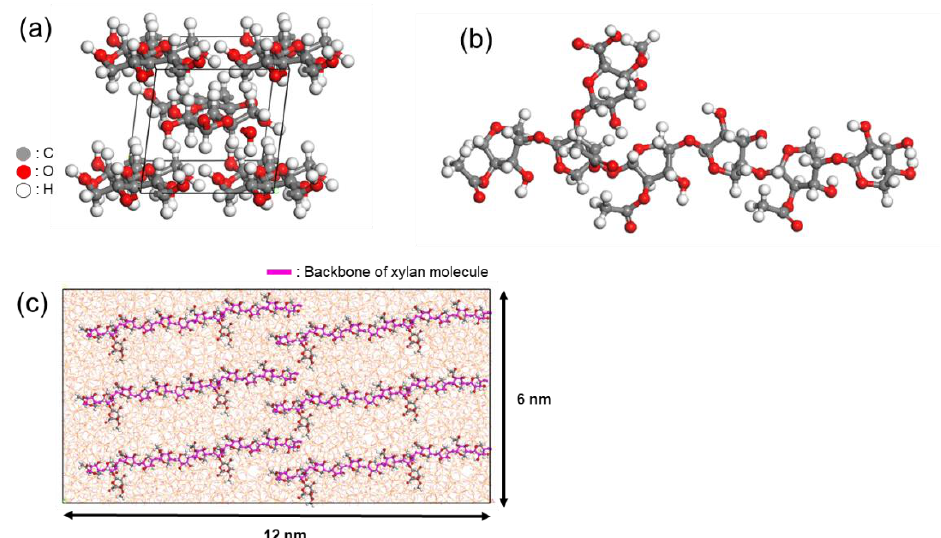
Figure 7. ( a ) Monoclinic crystalline structure of cellulose-Iβ. ( b ) Structure of Glucuronoxylan (xylan) hemicellulose molecule. ( c ) Bottom view of stretched configuration of 6 xylan molecules under the surface of cellulose film.